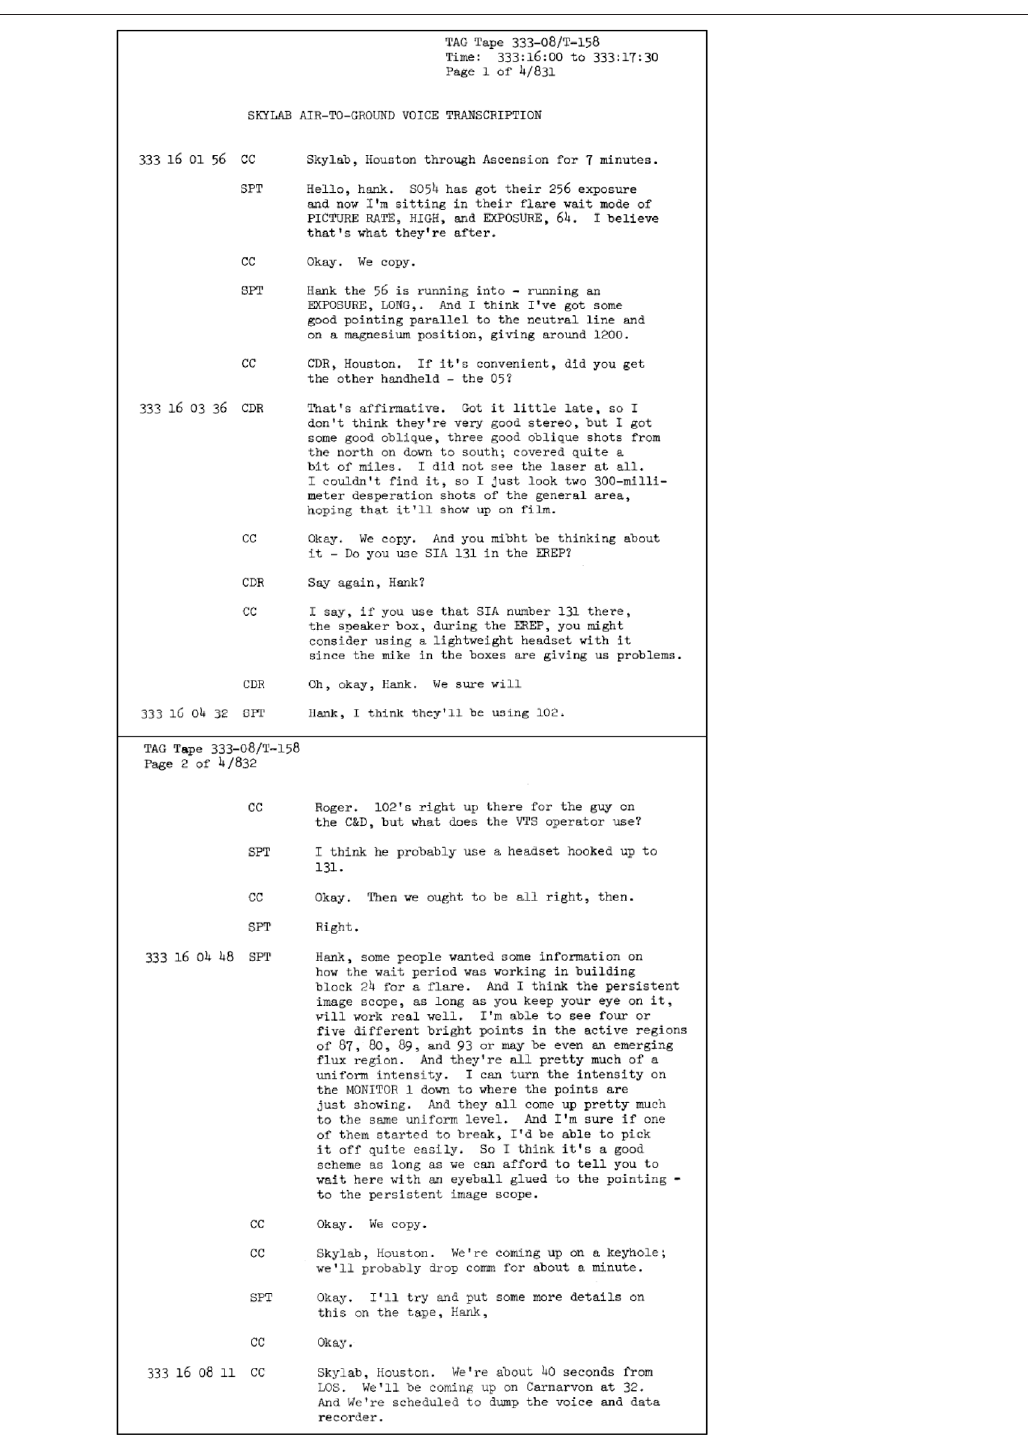
FIGURE 6 | NASA excerpt 1 — scienti fi c reporting on